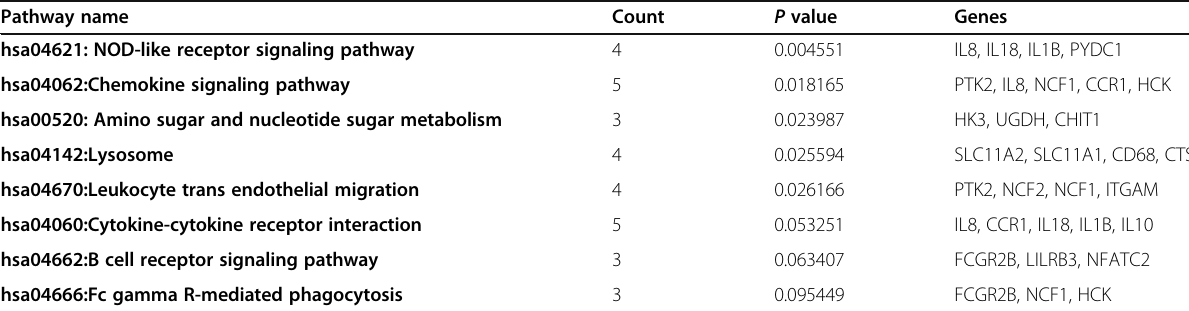
Table 1 The results of pathway enrichment analysis for the ODEGs Pathway name